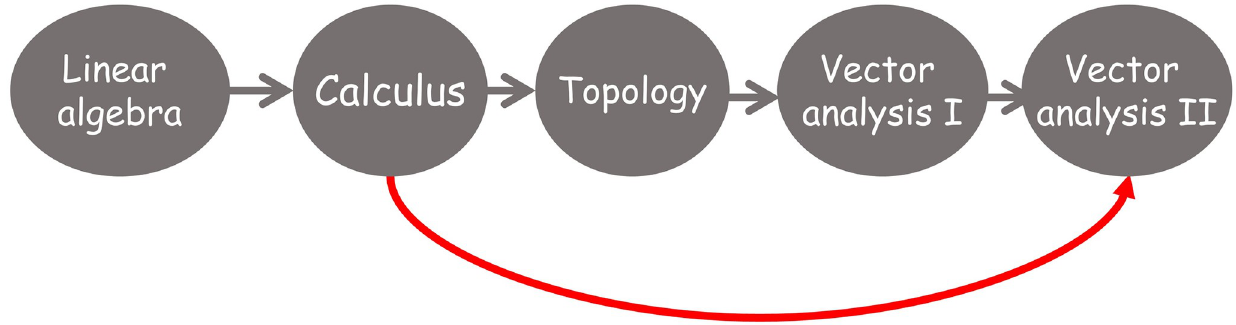
Fig 7. Example of non desirable assignment of courses to minimize the total length of paths joining dependent